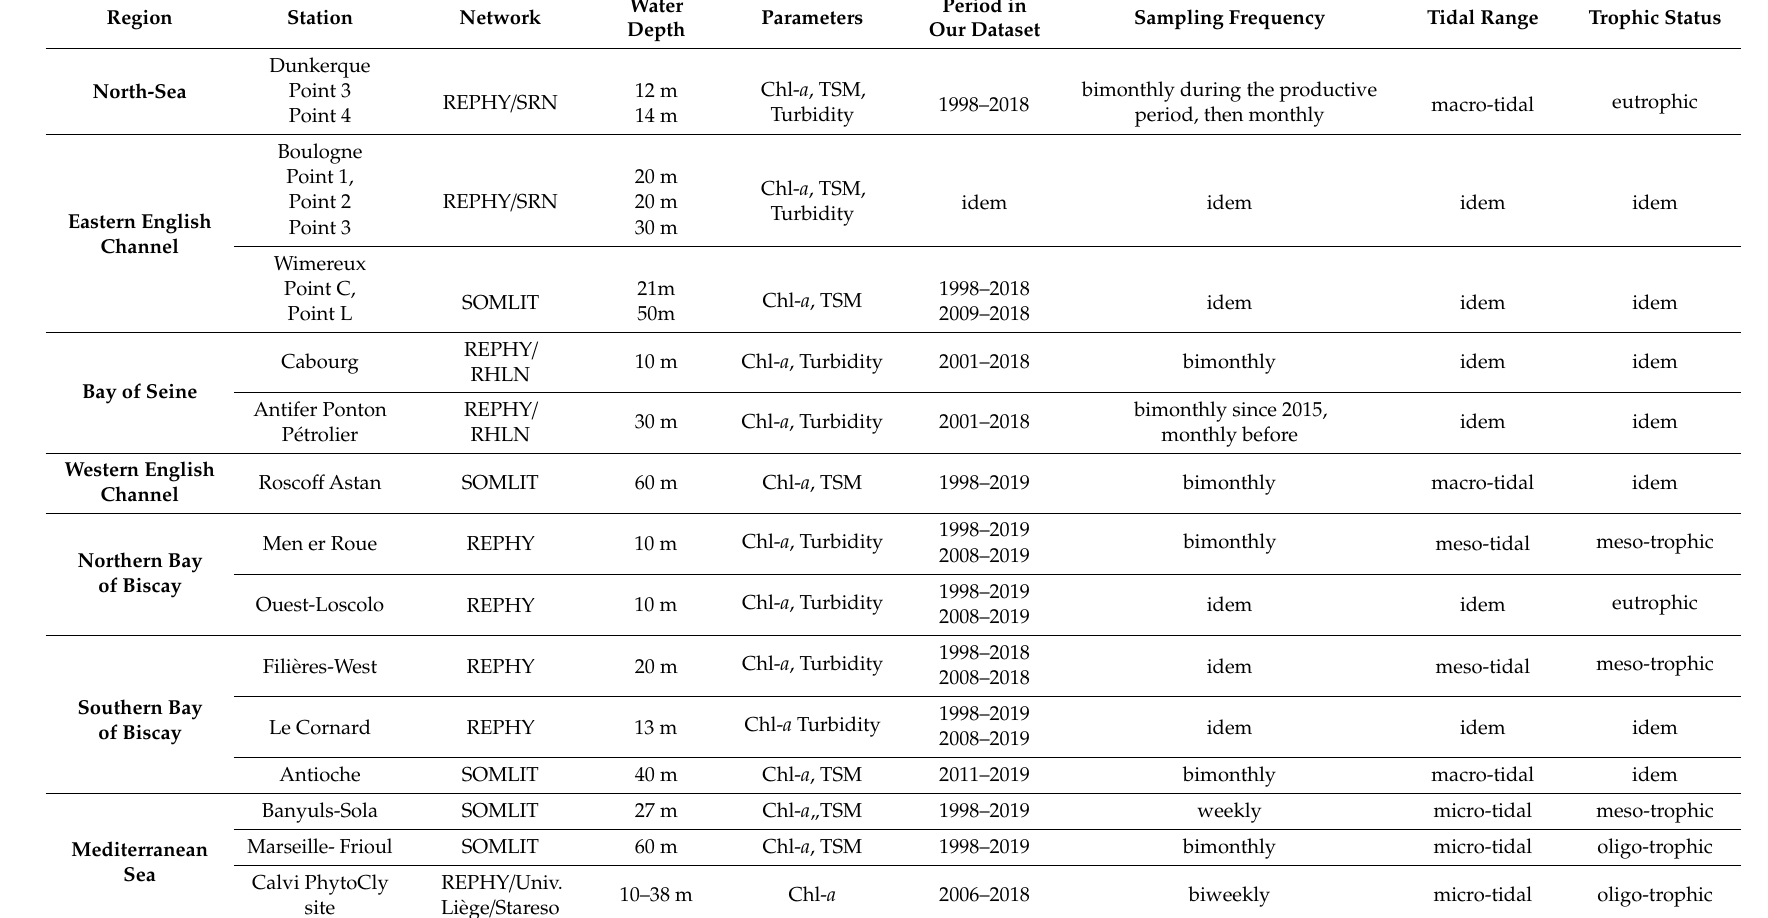
Table 1. Characteristics of the selected